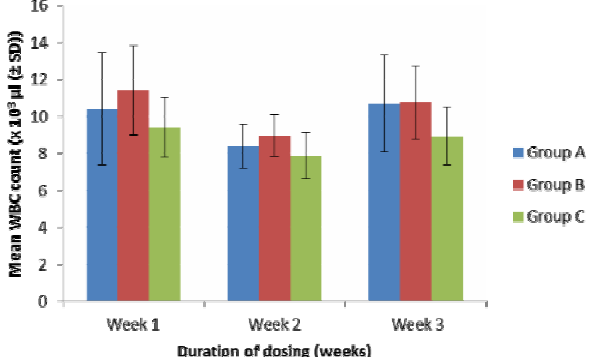
Fig. 3. The mean haemoglobin concentration (g/dl) (± SD) of rat groups given varied doses of methanolic leave extract of T. occidentalis . Group A (untreated control), group B (200 mg/kg body weight daily) and group C (800 mg/kg body weight daily)